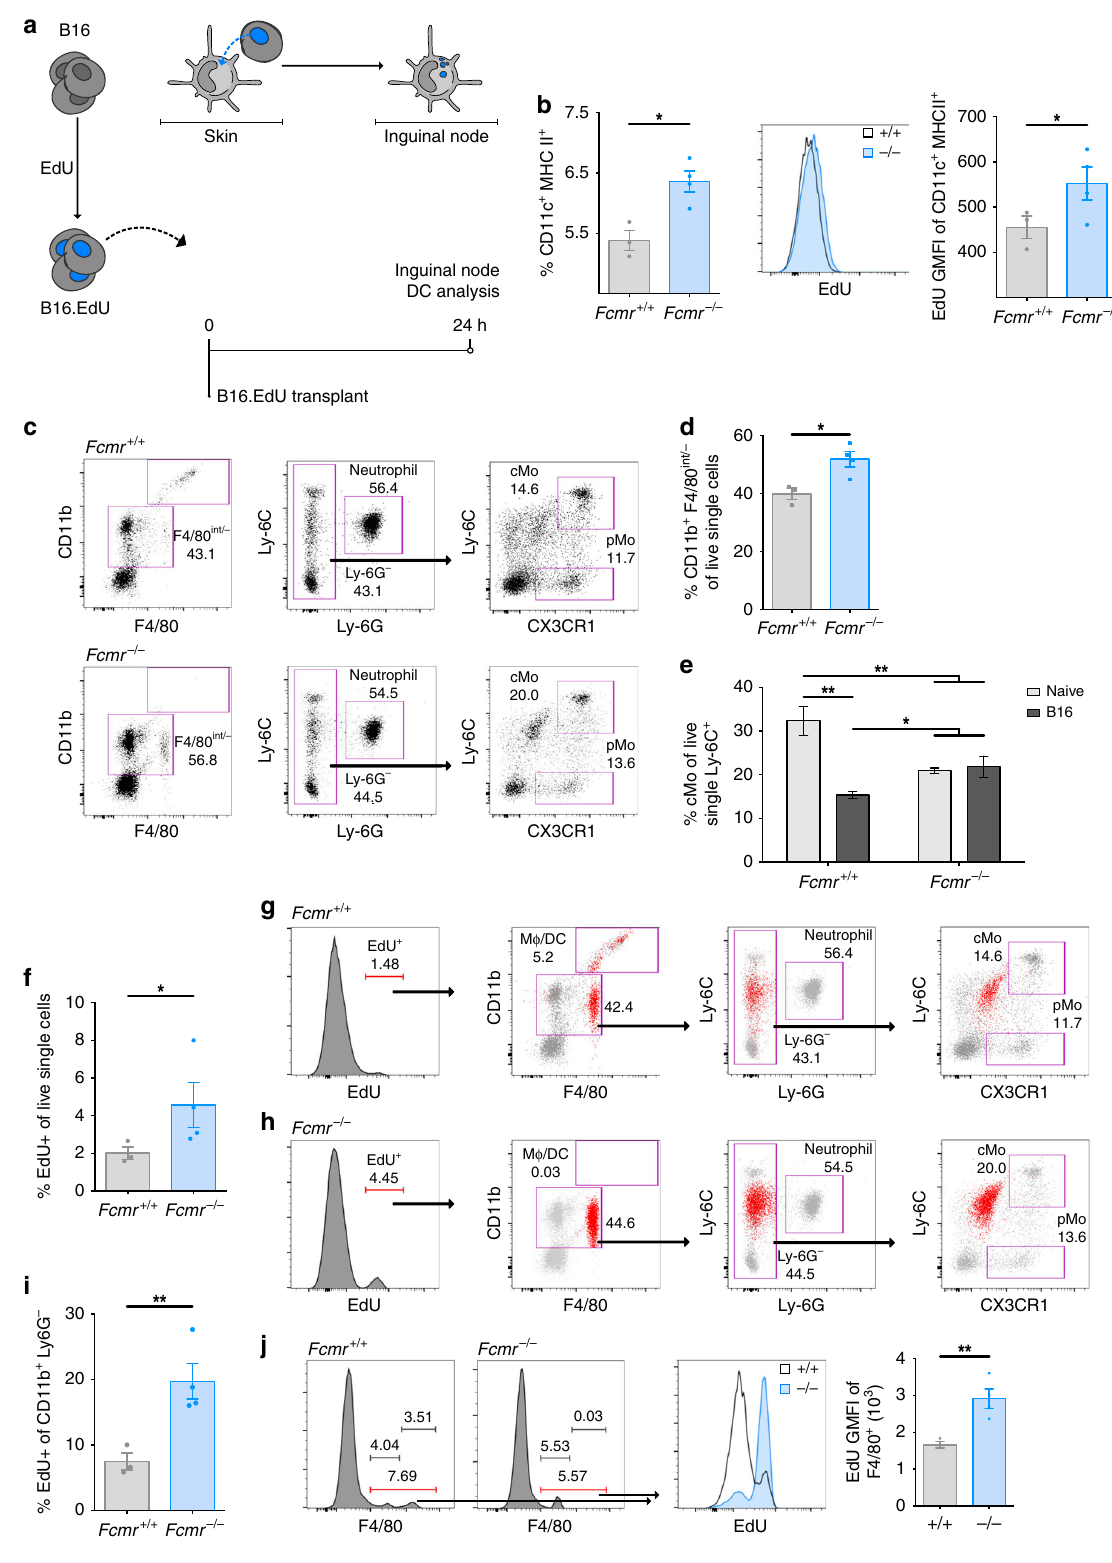
co-cultured with Fcmr − / − BMDCs had proliferated substantially more than those co-cultured with Fcmr + / + BMDCs (Supple- mentary Figs. 5e and 6b). This difference in cell divisions was further exacerbated at 72 h after the initiation of co-culture (Fig. 5f; Supplementary Fig. 6c, d). Accordingly, the replication and proliferation indexes of CD8 α + T cells co-cultured